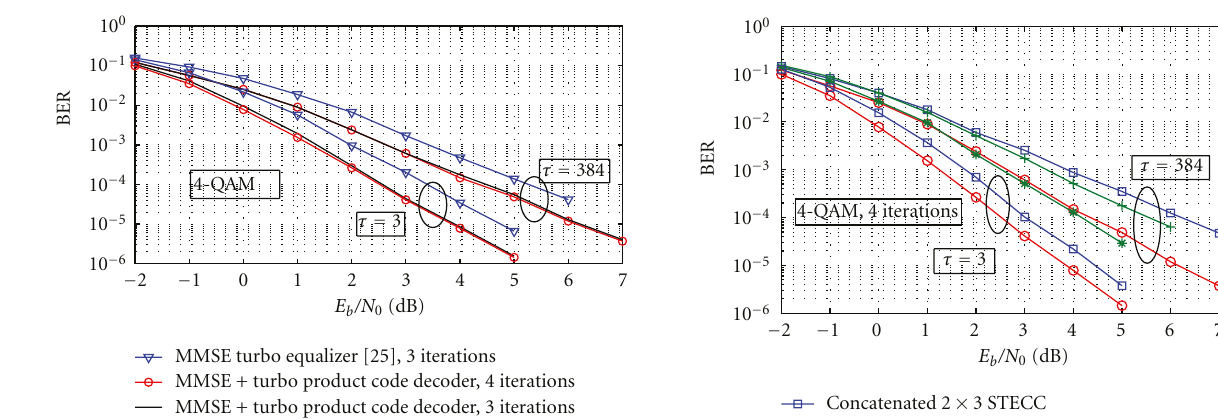
Figure 5: Performance comparison between the MMSE turbo receiver of [25] and the proposed iterative receiver (see Figure 3). Concatenated 2 × 3 full diversity STECC. 1530 informations bits. n CC (7,5) . Figure 6: Performance comparison of the concatenated full diver- r = 2. oct